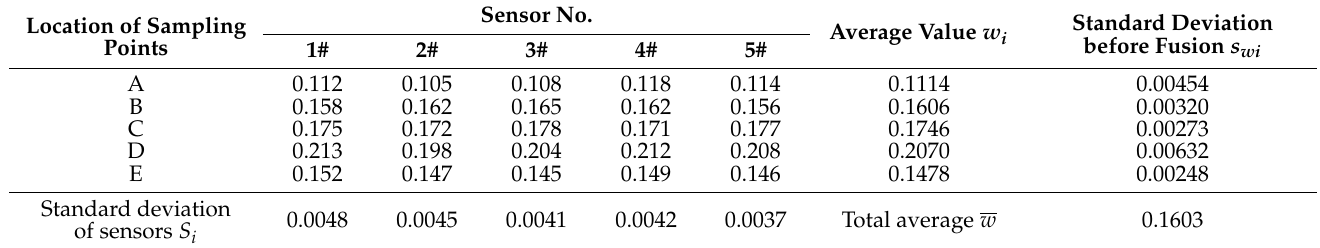
Table 2. List of detection values of each sensor at different detection points and their average values